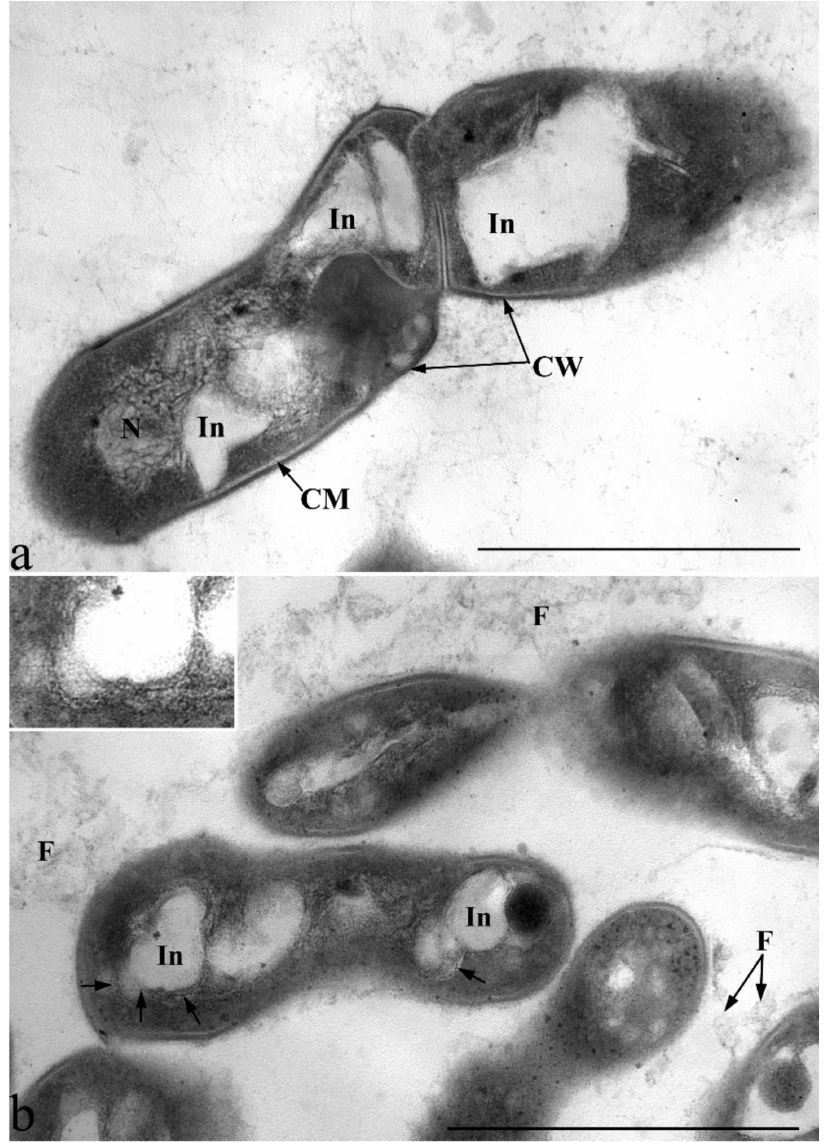
Figure 12. Ultrastructural organization of cells of strain S8 during growth on glucose (exponential growth phase) ( a ) and under growth conditions on dodecane (4 days) ( b ). Transmission electron microscopy. Ultrathin sections. Designations: N-nucleoid; CM—cytoplasmic membrane; CW—cell wall; In-electron-transparent inclusions; F—fibrillar surface structures. Arrows show membrane-like structures, which are also shown in the enlarged fragment in the inset in ( b ). Bar—1 µ